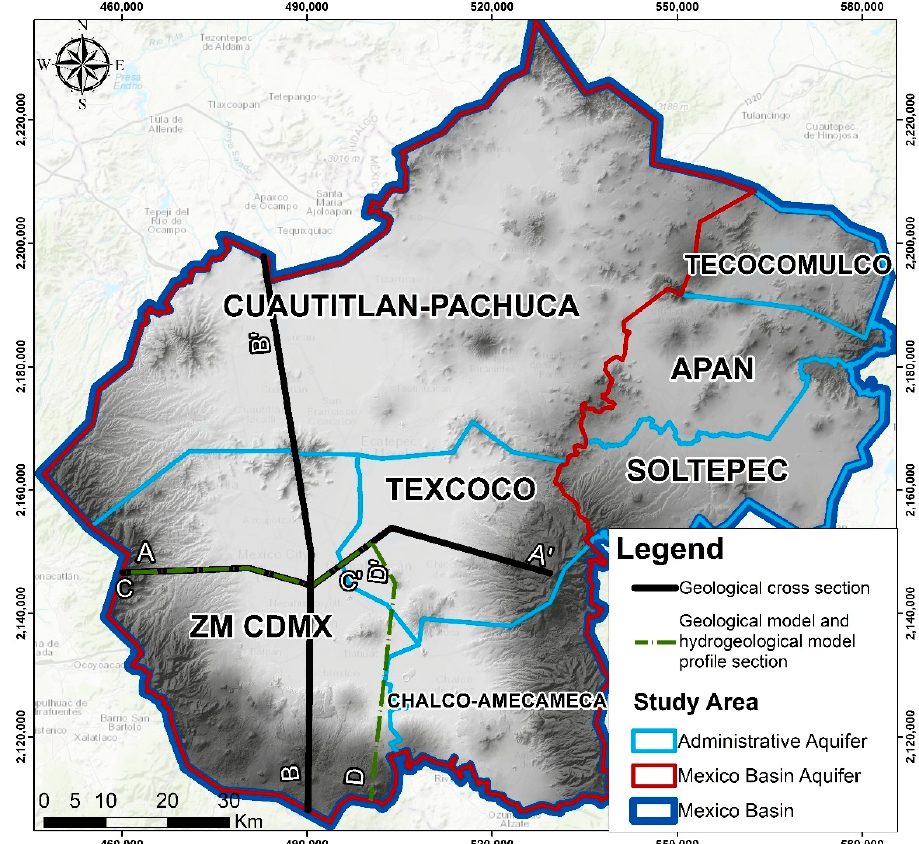
Figure 4. Administrative aquifers and geological cross sections used to display the geological and hydrogeological